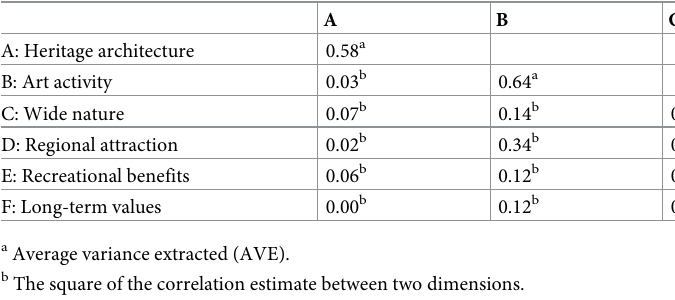
Table 4. Discriminant validity between the six dimensions of heritage tourism from the initial first-order six-factor